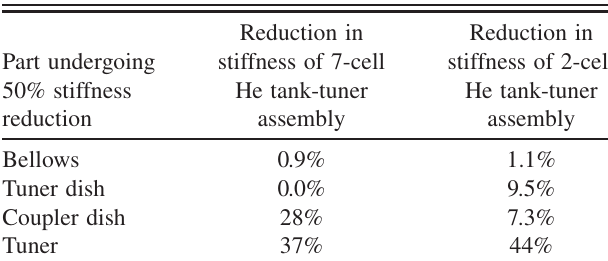
TABLE III. Percent reduction in overall stiffness of the He tank-tuner assembly as a result of a 50% reduction in the stiff- ness of one of its parts.